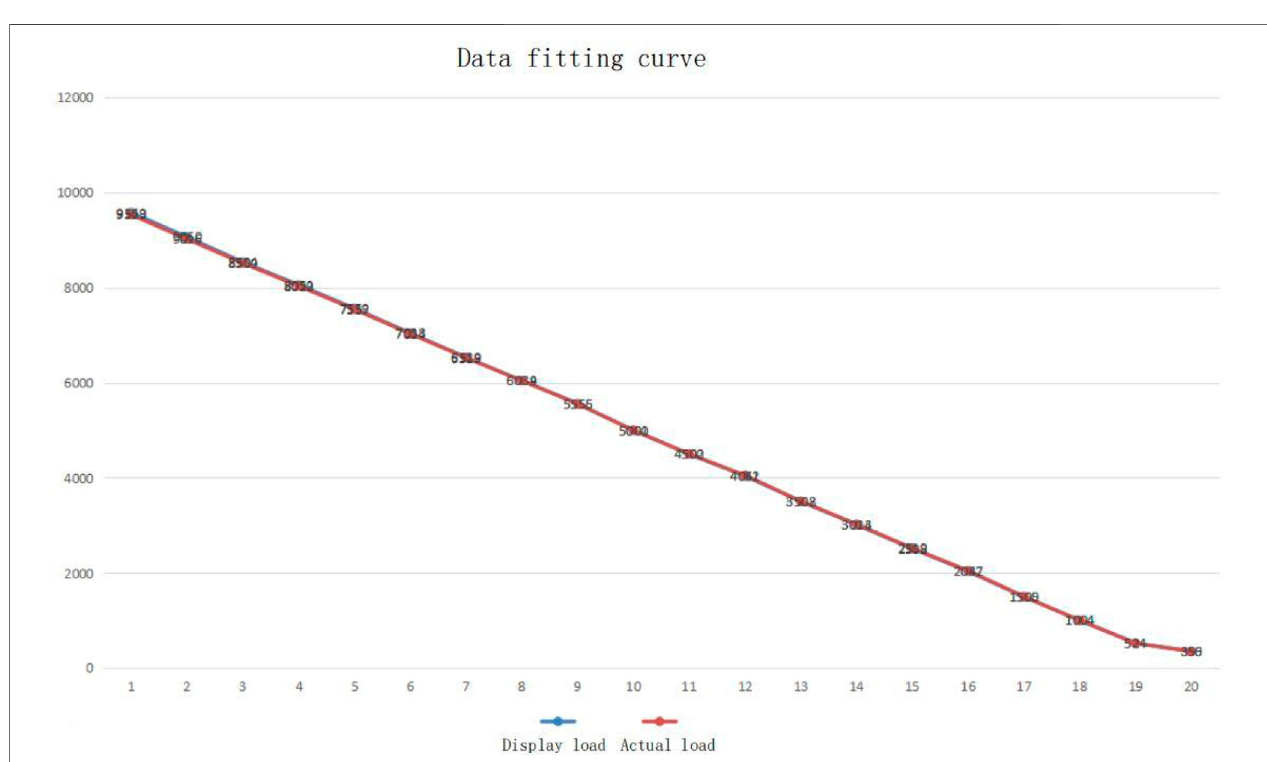
FIGURE 6 | Fitting image of collected data and applied